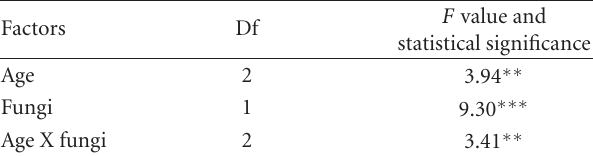
Figure 2: White rot hyphae penetration in fibre lumen (cross section, 618x). Table 5: ANOVA Results on culms percentage weight loss.